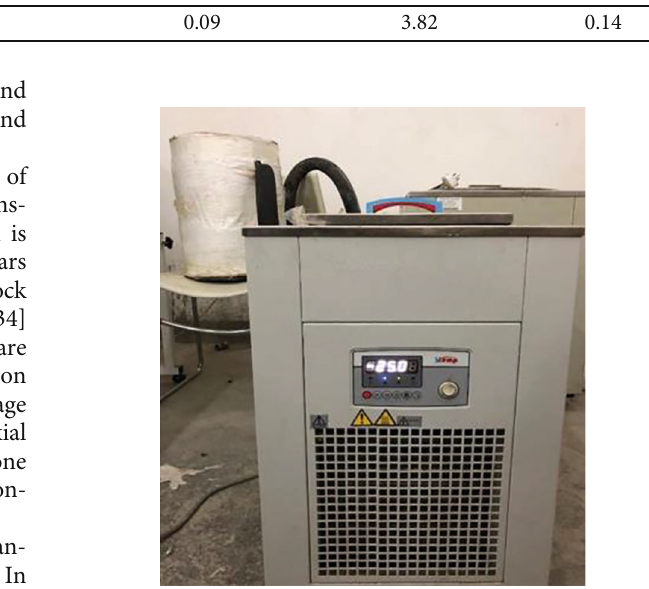
Figure 2: TDS-300 freeze-thaw cycle testing machine.